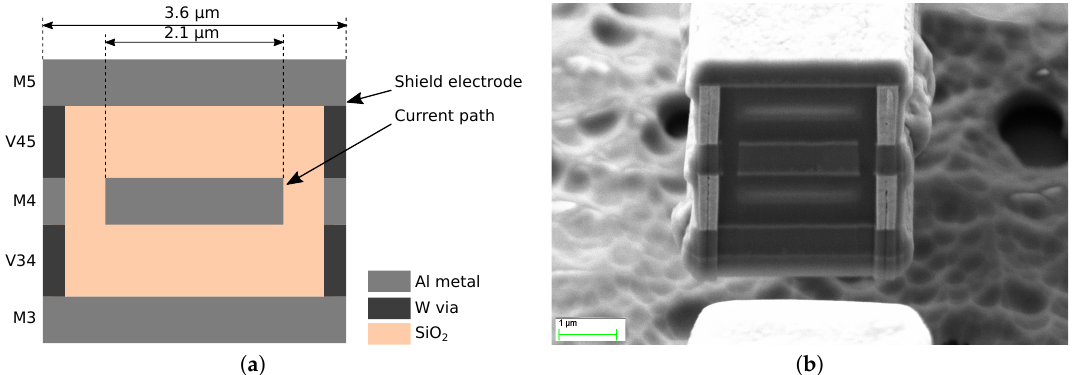
Figure 4. Device spring cross-section diagram ( a ) and image after a Focused Ion Beam (FIB) cut ( b ). Same as the rotor, the spring is made of a stack of M3–M5 metals and vias that surround the current carrying path at